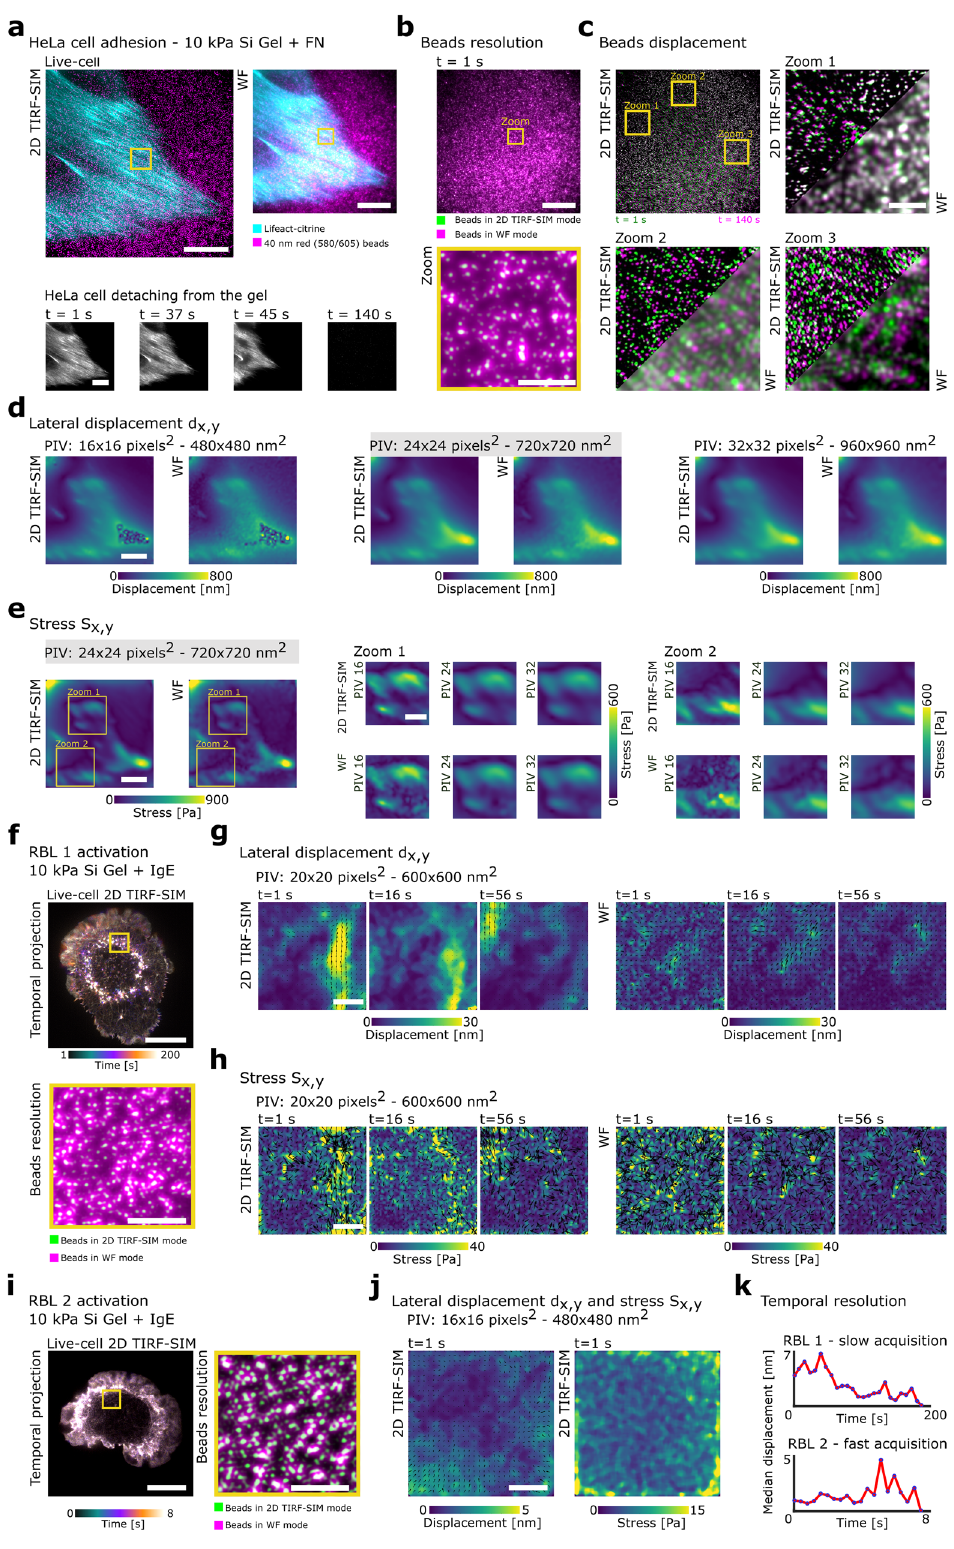
fl uorescent displacement distributions for three PIV window sizes (Fig. 2d). Consistent with visual inspection of the simulated SVD quality metric (Supplementary Fig. 1a, b), the PIV analysis con fi rmed the optimal choice of 720 nm × 720 nm PIV window size for an overall maximum displacement of 800 nm (Fig. 2d and Supplementary Fig. 1c). In contrast, a selection of a smaller